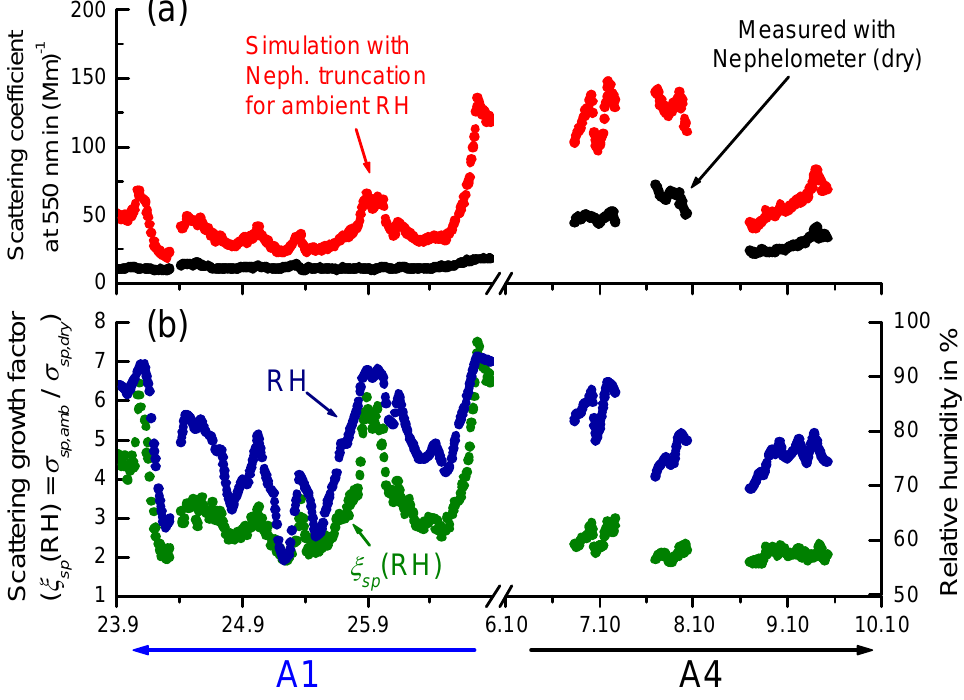
Fig. 11. Optical simulations under ambient conditions for both marine (A1, 23–25 September 2005) and continentally polluted (A4, 6–9 October 2005) cases: (a) simulated aerosol scattering coefficient (550nm) under ambient conditions vs. the aerosol scattering coefficient (550nm) measured by a nephelometer at dry conditions. (b) ambient RH and scattering growth factor ( ξ sp (RH) = σ sp , amb /σ sp , dry ). The experimental scattering coefficients were corrected for the non-idealities (truncation) of the